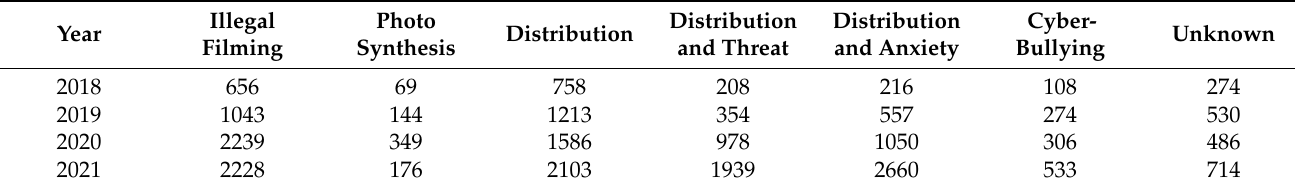
Table 3. Types of Digital Sex Crimes by